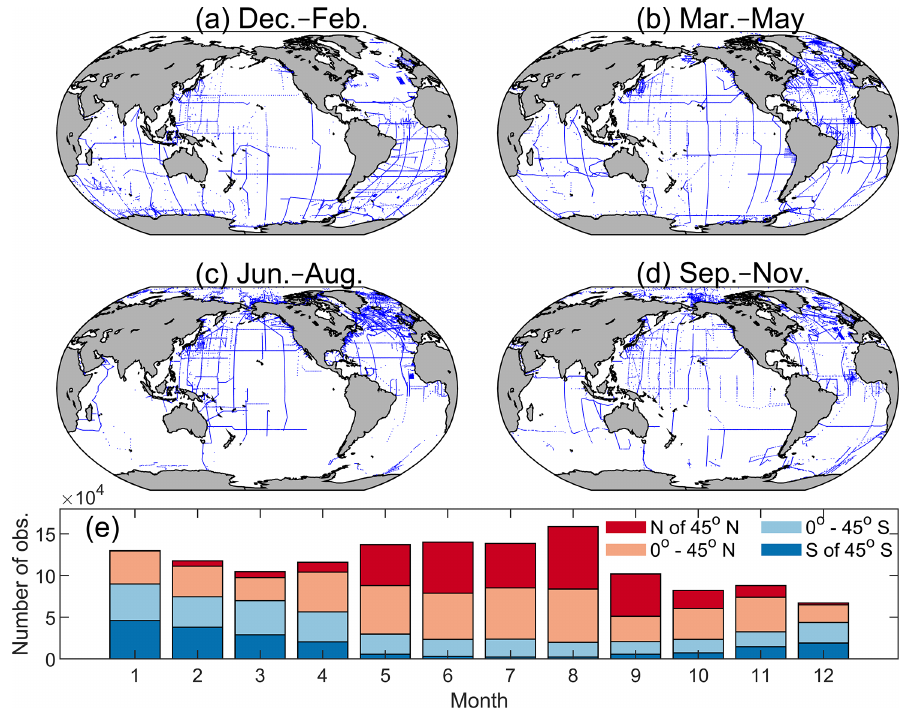
Figure 10. Distribution of data in GLODAPv2.2022 in (a) December–February, (b) March–May, (c) June–August, and (d) September– November, as well as (e) number of observations for each month in four latitude